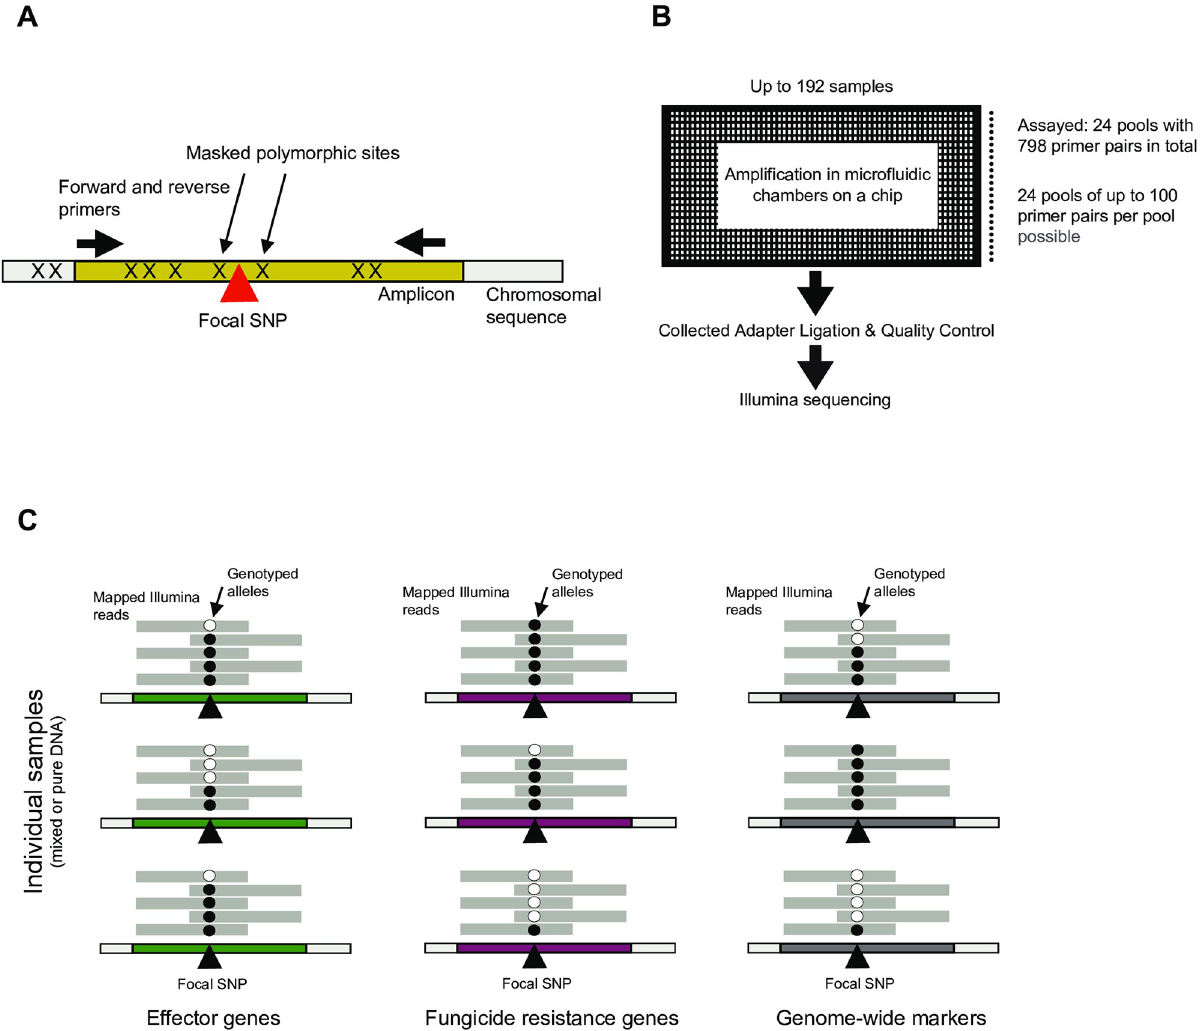
Fig 1. Schematic overview of the targeted amplicon assay design. A) Design of individual amplicons (~200 bp) with primers designed to not overlap known polymorphic sites. B) Schematic overview of the microfluidic chambers of a Fluidigm Juno chip accommodating up to 192 samples and 24 pools of primers (each up to 100 primer pairs). Following amplification in microfluidic wells, barcoded products are pooled and finalized for Illumina sequencing. C) Genotypes of individual samples (pure or mixed individuals) are assessed by analyzing mapped reads at each locus in the genome. Markers were designed for three different categories including effector genes, genes encoding targets of fungicides and genome-wide evenly spaced